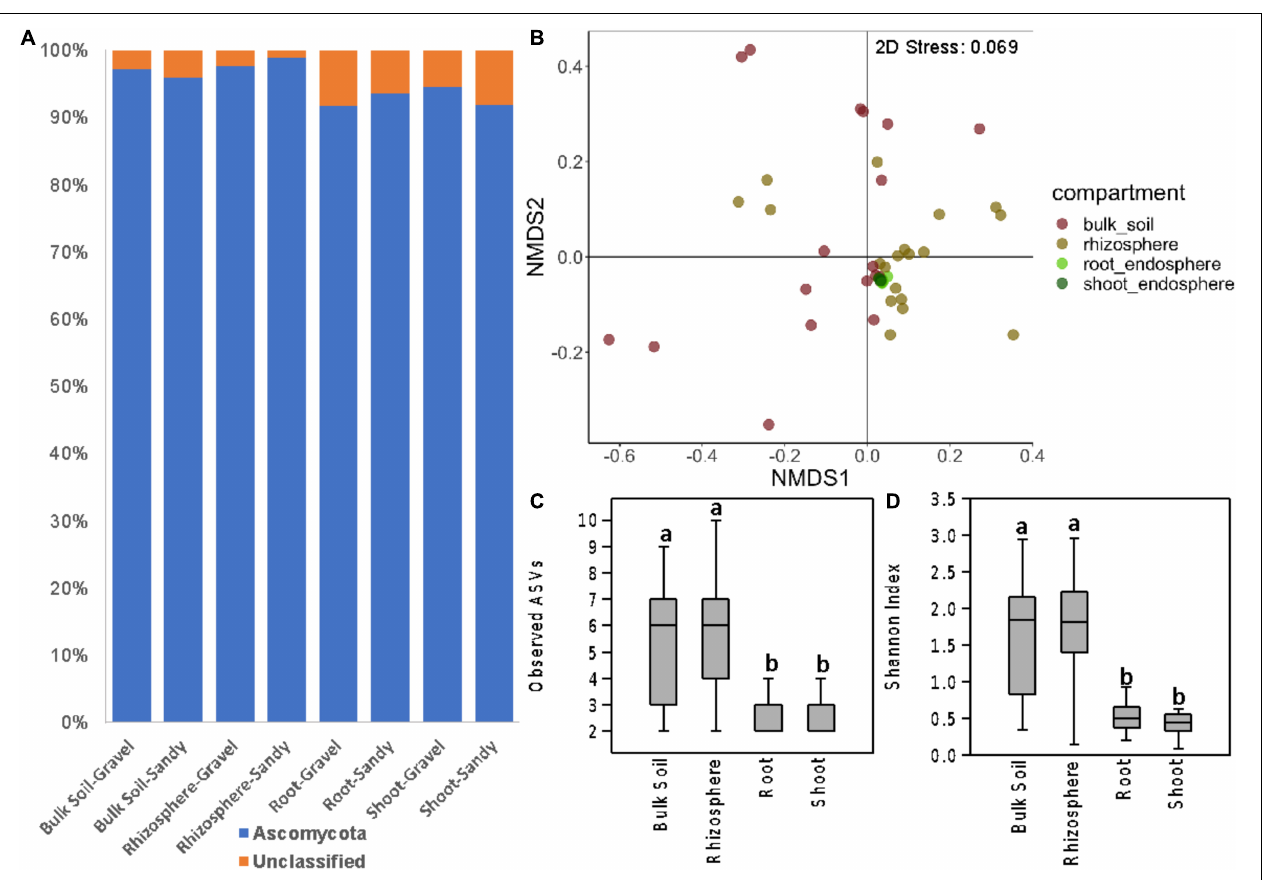
FIGURE 4 | Fungal community composition and diversity in all sampling compartments. (A) Bar charts showing the relative abundance of fungal phyla in bulk soil, rhizosphere, root endosphere, and shoot endosphere samples of plants growing in gravel or sandy soils. (B) Fungal community structure represented by a non-metric multidimensional scaling (NMDS) ordination based on the Bray-Curtis distance matrix of the ITS ASV table. Samples are colored according to the sampling compartment. (C,D) Differences in fungal alpha-diversity between the four plant and soil compartments. (C) Fungal species richness based on the number of observed ASVs. (D) Fungal species diversity based on the Shannon index. Distinct letters indicate significant differences according to the Kruskal-Walli’s test ( p <